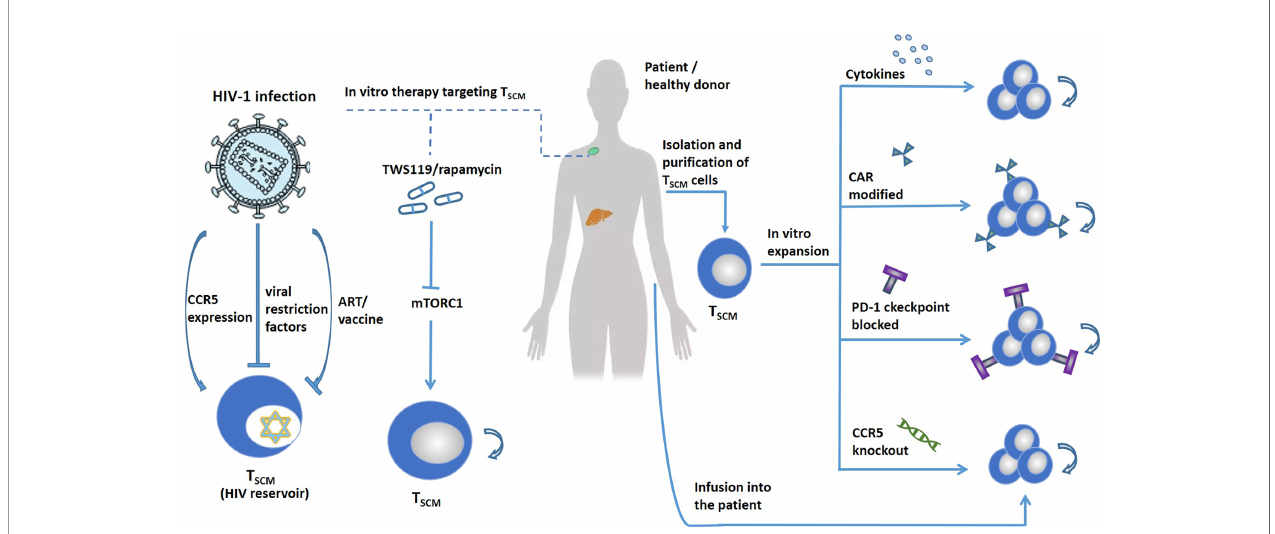
FIGURE 5 | Target T SCM cells to treat human diseases. T SCM cells can exacerbate human disease. Left, treat T SCM -driven diseases, such as autoimmune diseases, HIV, etc., by blocking the production of T SCM . The expression of CCR5 promotes the infection of T SCM cells with HIV. Viral restriction factors and vaccines can target T SCM cells to treat HIV. Blocking the mTORC1 pathway promotes the self-renewal and differentiation of T SCM . Right, T SCM cells are expanded in vitro by adding cytokines, CAR modi fi cation, immune checkpoint blocking, and gene editing. Stars represent cells latently infected with